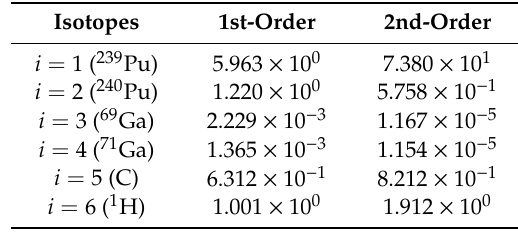
Table 3. Comparison of 1st-order relative sensitivities and unmixed 2nd-order relative sensitivities all